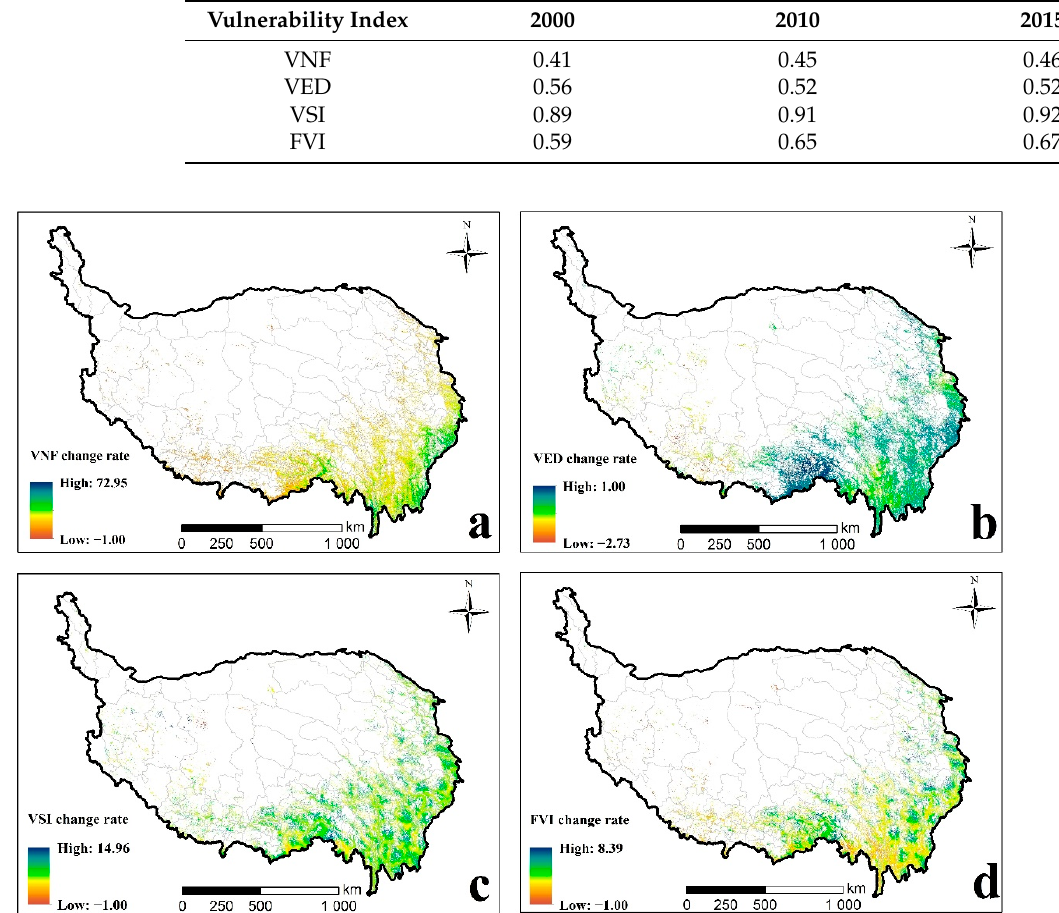
Figure 8. Spatial distribution of VNF change rate ( a ), VED change rate ( b ), VSI change rate ( c ), and FVI change rate ( d ) from 2000 to 2015.